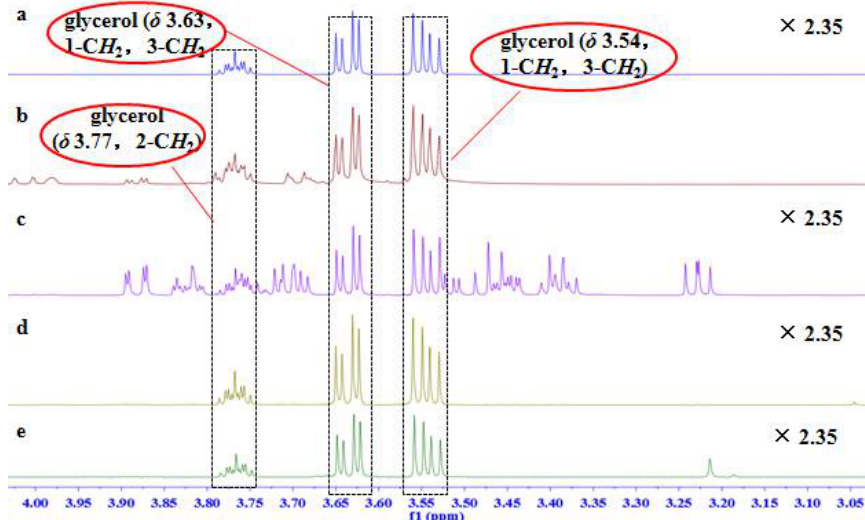
Figure 1. Enlarged 1 H NMR spectra from δ 3.05 to δ 4.00 of ( a ) homemade testing sample; ( b ) glycerol fructose and sodium chloride injection (GFS); ( c ) Shenxiong glucose injection (SXG); ( d ) Xiaozhiling injection (XZL); and ( e ) etomidate injectable emulsion (EIE).